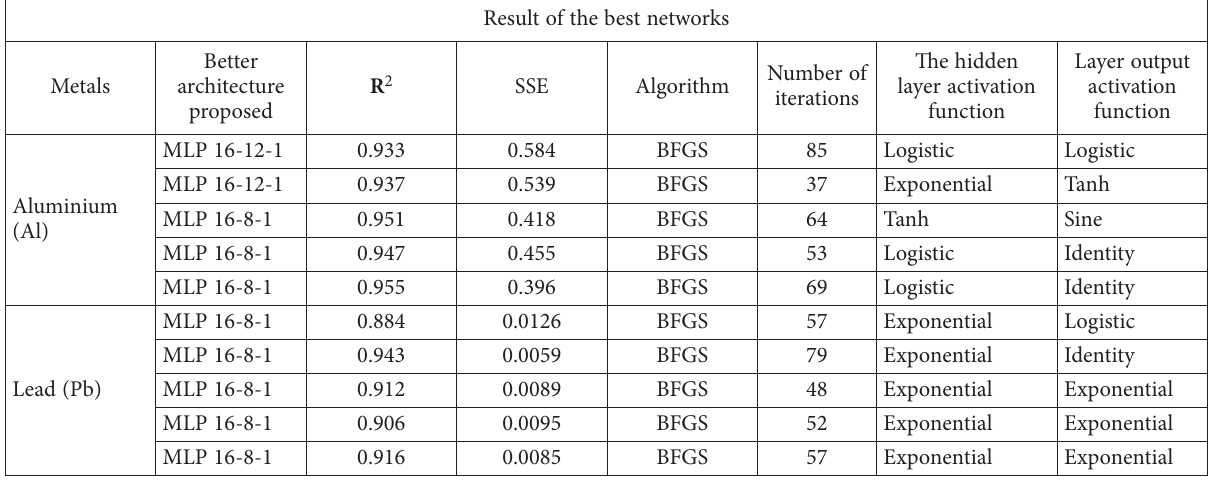
Table 4. Recap of the five best architectures offered by STATISTICA12 for Cu and Fe metal Result of the best networks